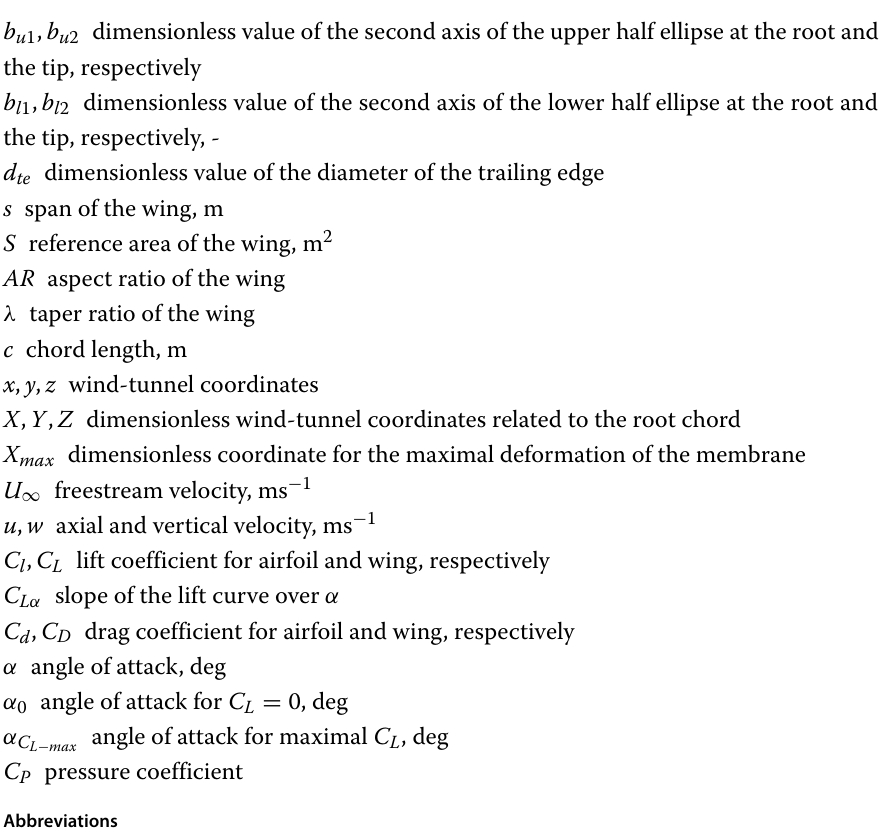
b u 1 , b u 2 dimensionless value of the second axis of the upper half ellipse at the root and at the tip,